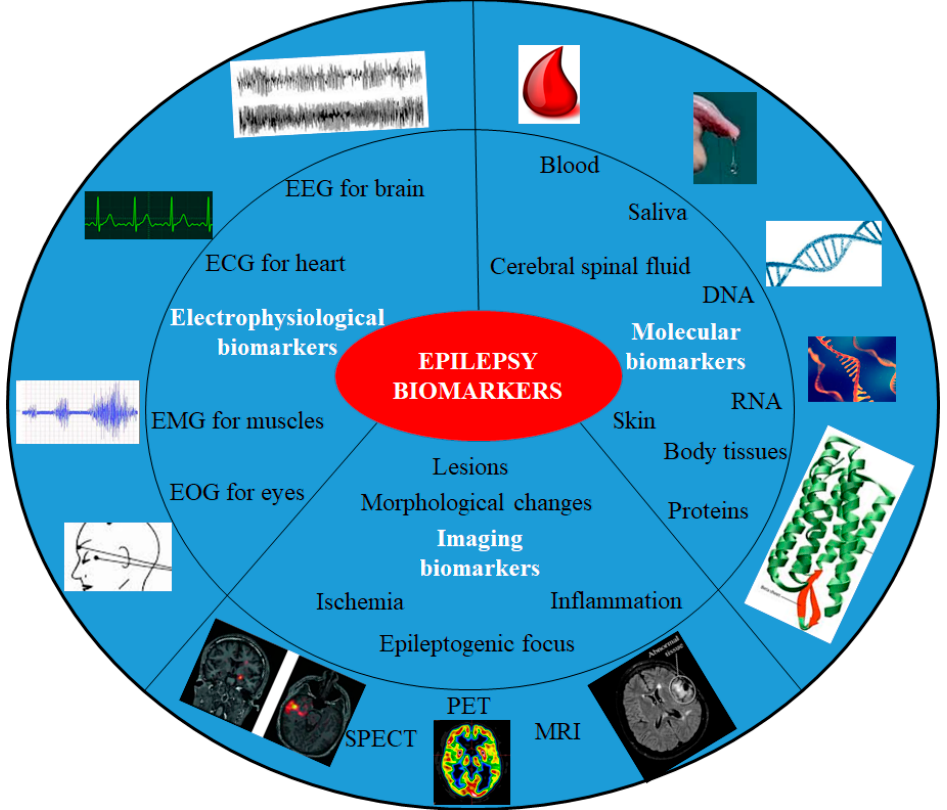
Figure 2. Schematics of biomarkers for the prediction of the epilepsy.